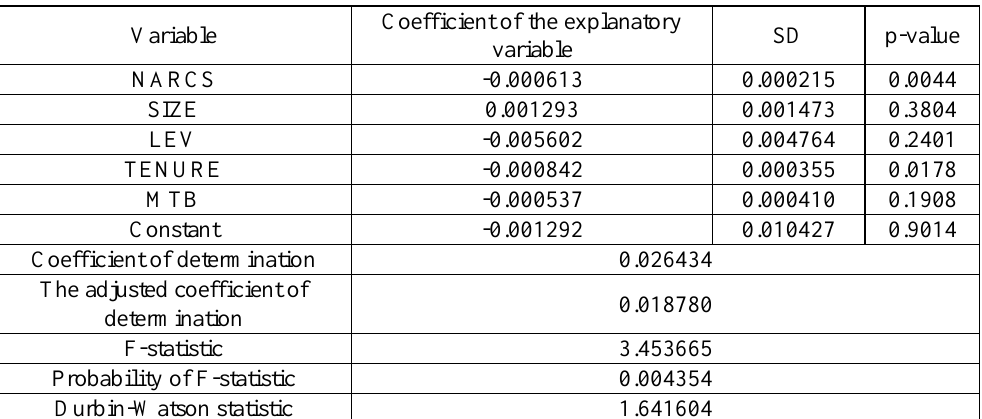
Table 8. Model fit for